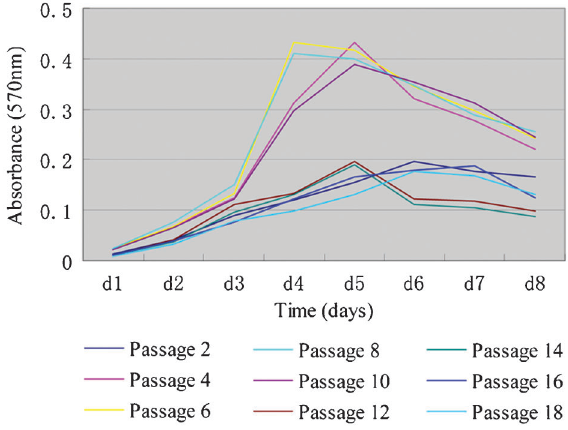
Figure 3. Growth curves of hepatic oval cells (HOCs) collected from different passages. The viability of HOCs from passage 2-18 was determined by 3-(4,5-dimethylthiazol-2-yl)-2,5-diphenyltetra- zolium bromide (MTT). Data are reported as means±SD.